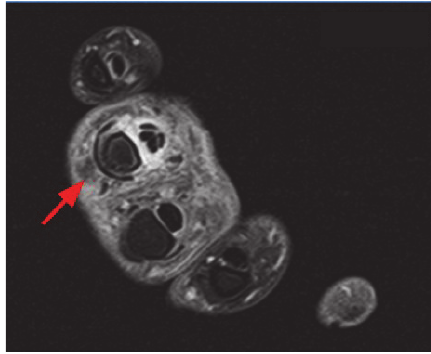
Figure 2: MRI axial view, postcontrast tenosynovitis.